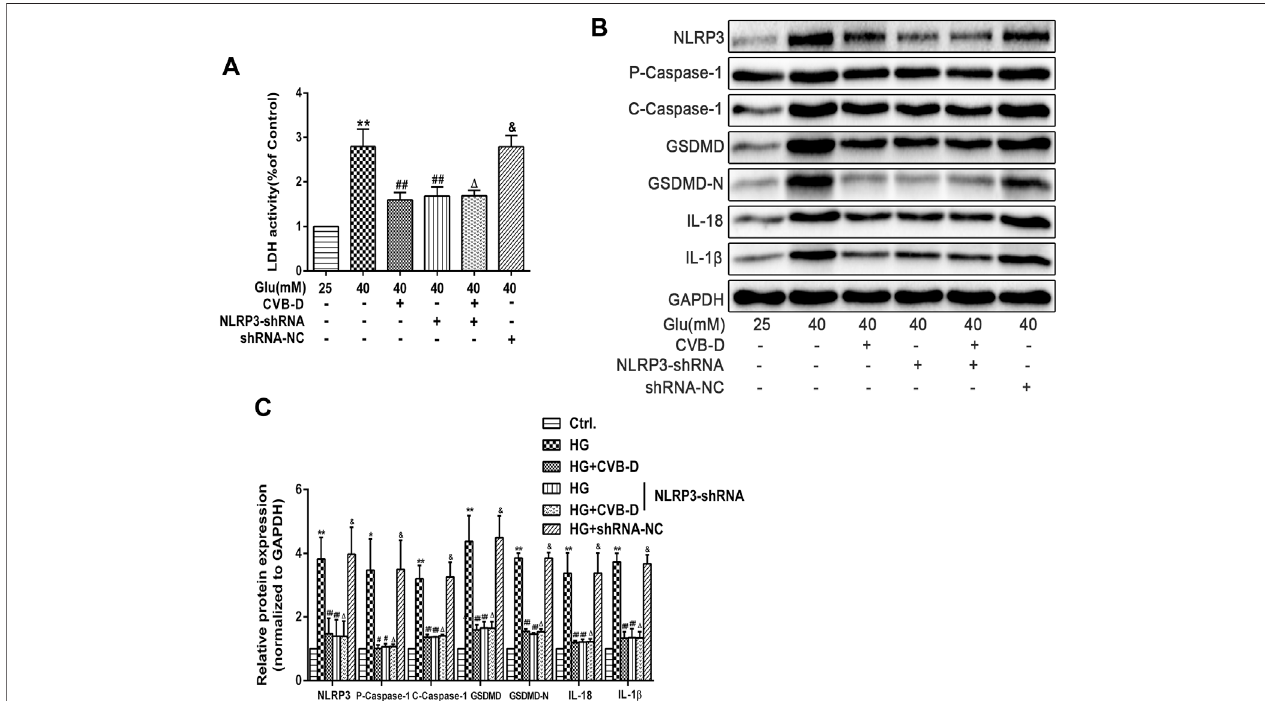
FIGURE 8 | NLRP3-shRNA veri fi es the regulation mechanism of CVB-D inhibition pyroptosis induced by HG in PNRCMs. (A) LDH release in cell culture supernatantwasdetectedafterNLRP3-shRNAlentivirus-infected. (B,C) WesternblottingwasusedtodetectedproteinsexpressioninpyroptosispathwayafterNLRP3- shRNA lentivirus infection withPNRCMs.Thedataare presented asthemean±SEM( n =3),* p < 0.05,** p < 0.01versusthecontrolgroup; # p < 0.05, ## p < 0.01versus the model group; Δ p > 0.05 versus the HG+NLRP3-shRNA group; & p > 0.05 versus the model group.